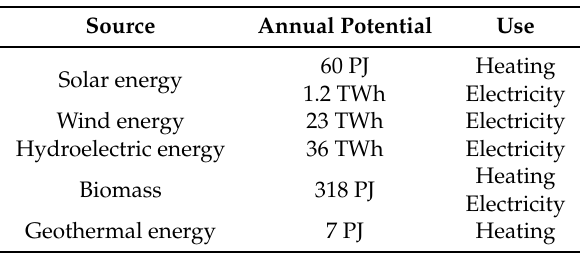
Table 3. Potential of renewable energy in Romania